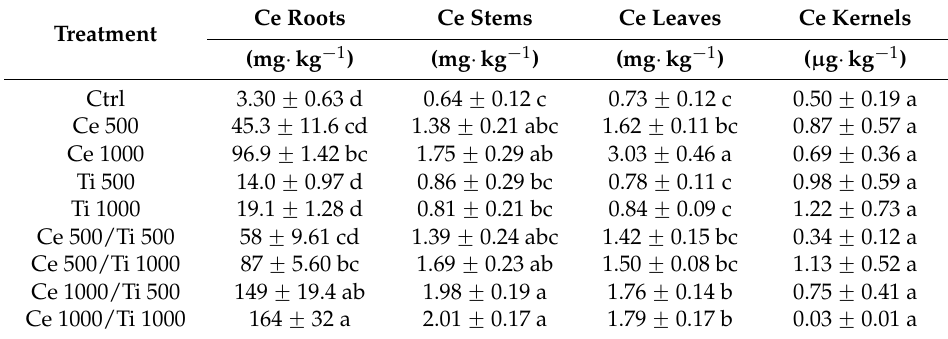
Table 2. Ce concentration observed in roots, stems, leaves and kernels of barley grown in control soil and n CeO 2 and n TiO 2 -amended soil. Values are mean ˘ SE. ( n = 5). Same letters indicated no statistical difference between treatments at Tukey’s test ( p ď 0.05).